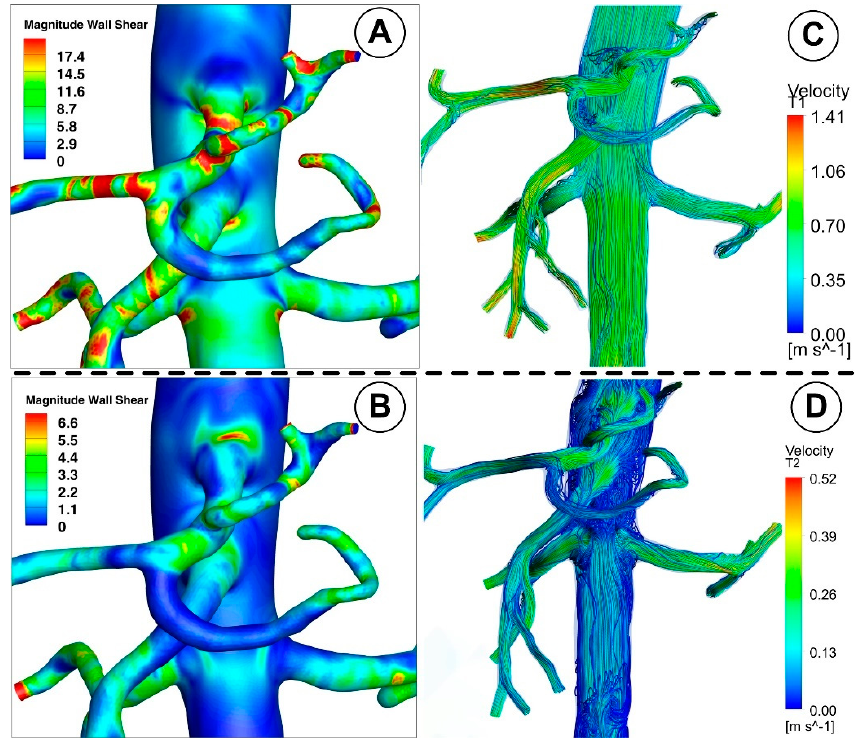
Figure 18. WSS contour in the renal arteries segment for different time steps ( A ) time T1, ( B ) time T2. The recirculation development is directly correlated with WSS evolution. Flow evolution is presented through path lines ( C ) time T1 and ( D ) time T2 .